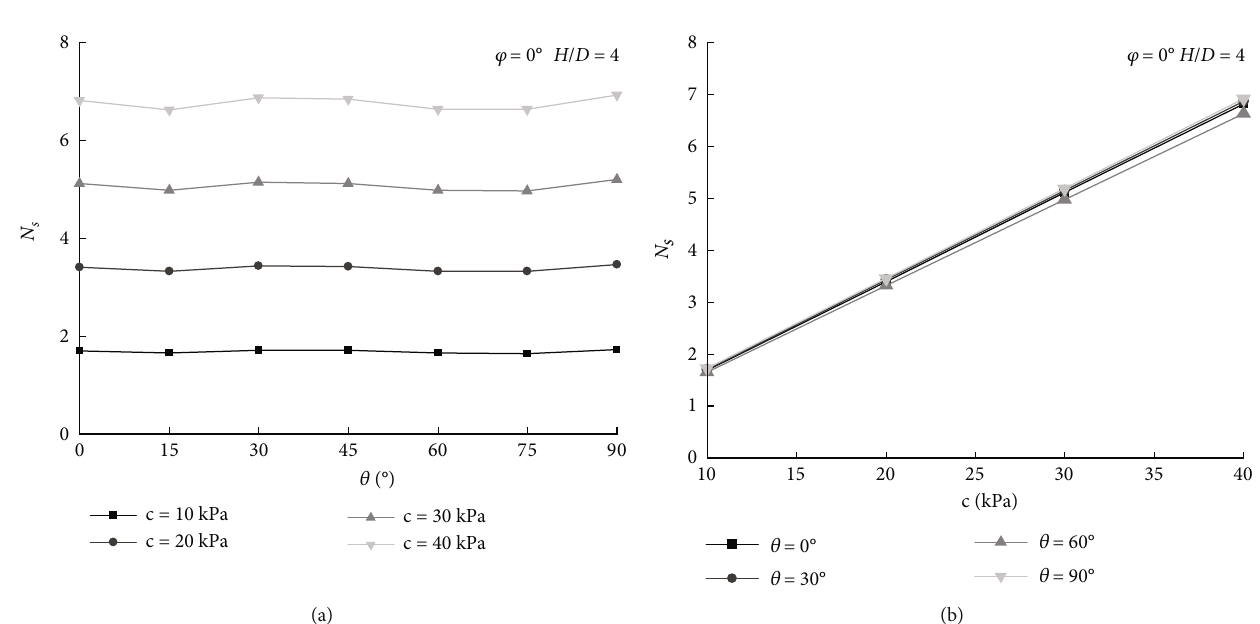
ff erent inclination angles for φ = 0 °